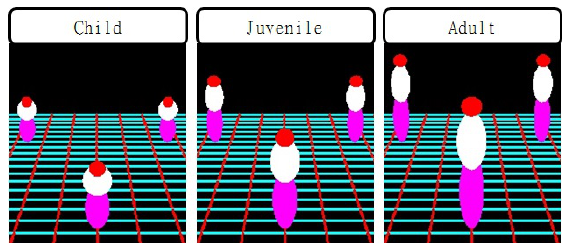
Figure 2. Human models on the projected multiple ellipses with different sizes and